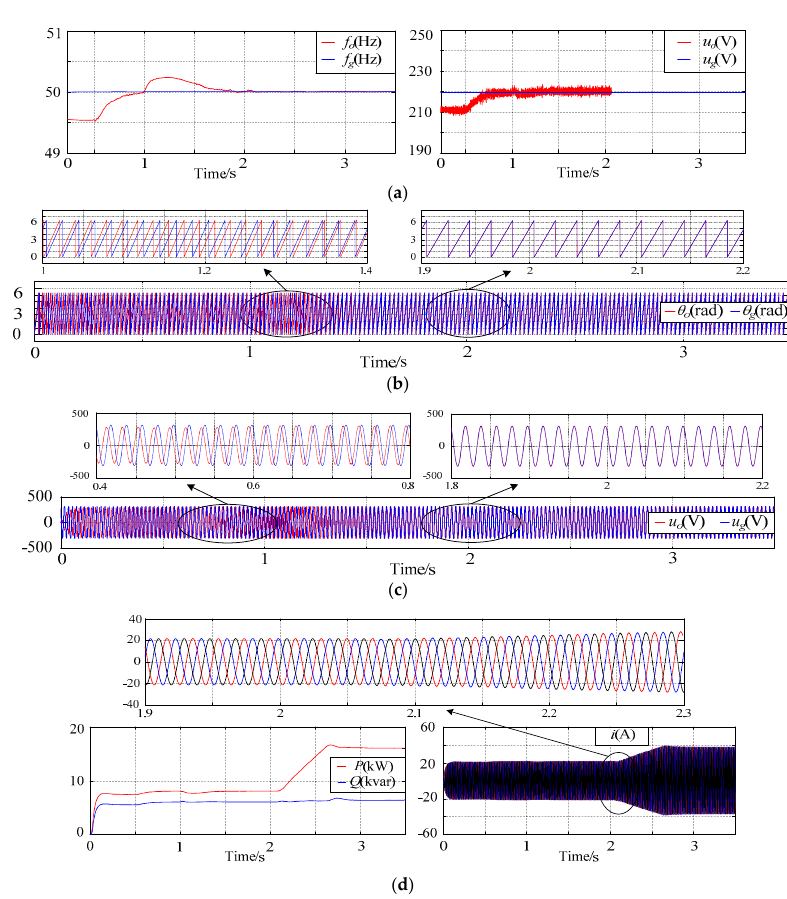
Figure 11. Simulation results of quasi-synchronization process: ( a ) The frequency and voltage amplitude regulation process; ( b ) The phase angle regulation process; ( c ) The change and comparison of inverter output voltage and grid voltage; ( d ) The power and grid-connected current regulation process.